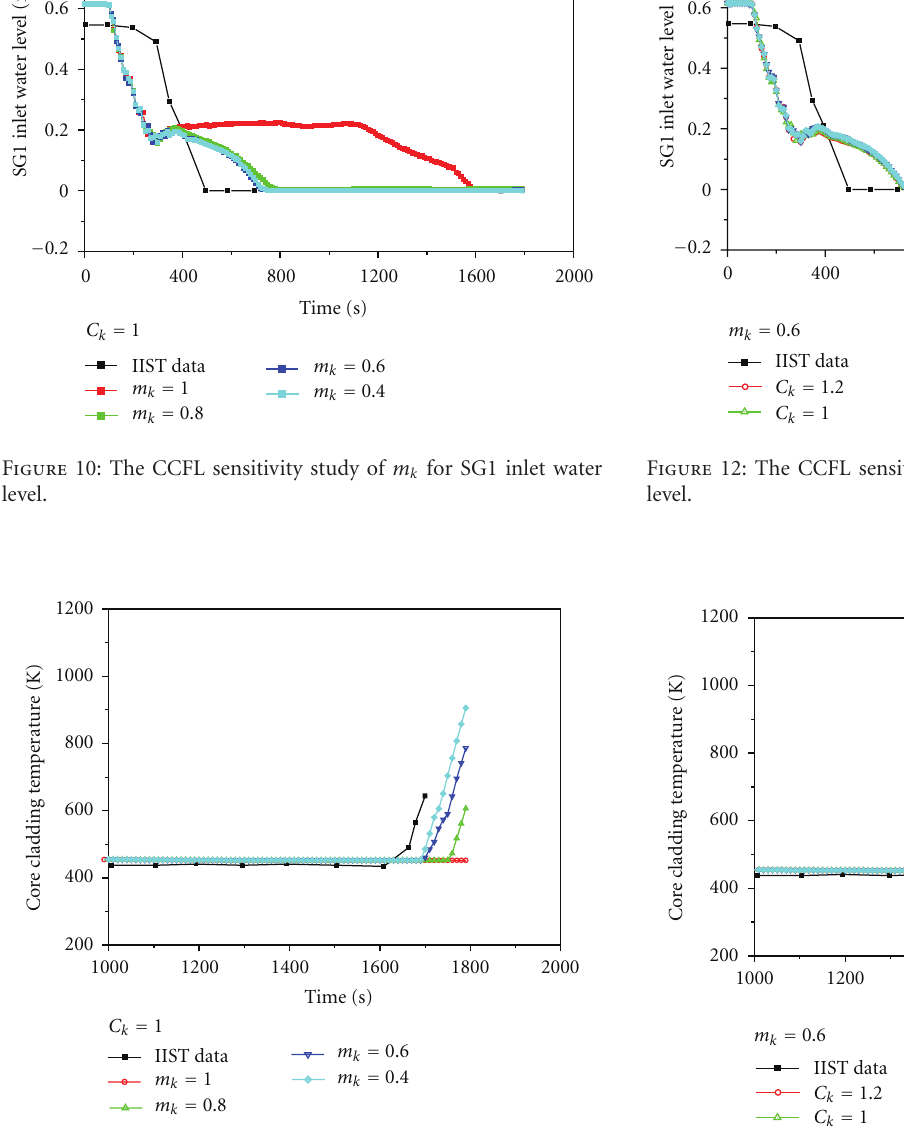
Figure 11: The CCFL sensitivity study of m k for core cladding temperature.